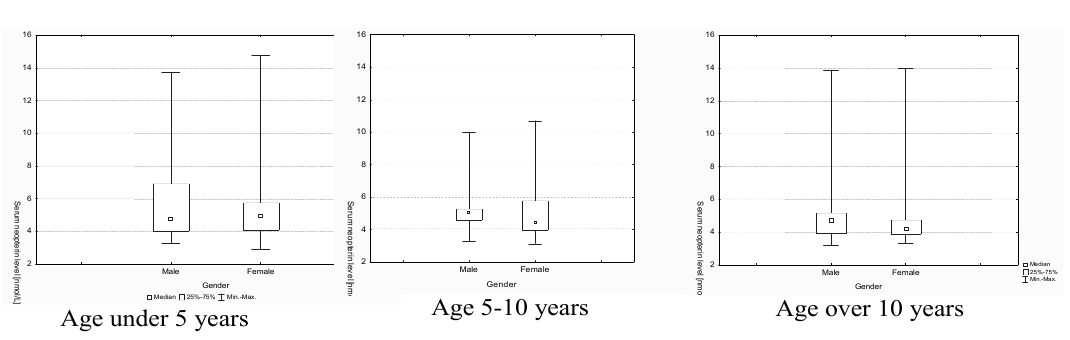
Median 25%-75% Min.-Max.